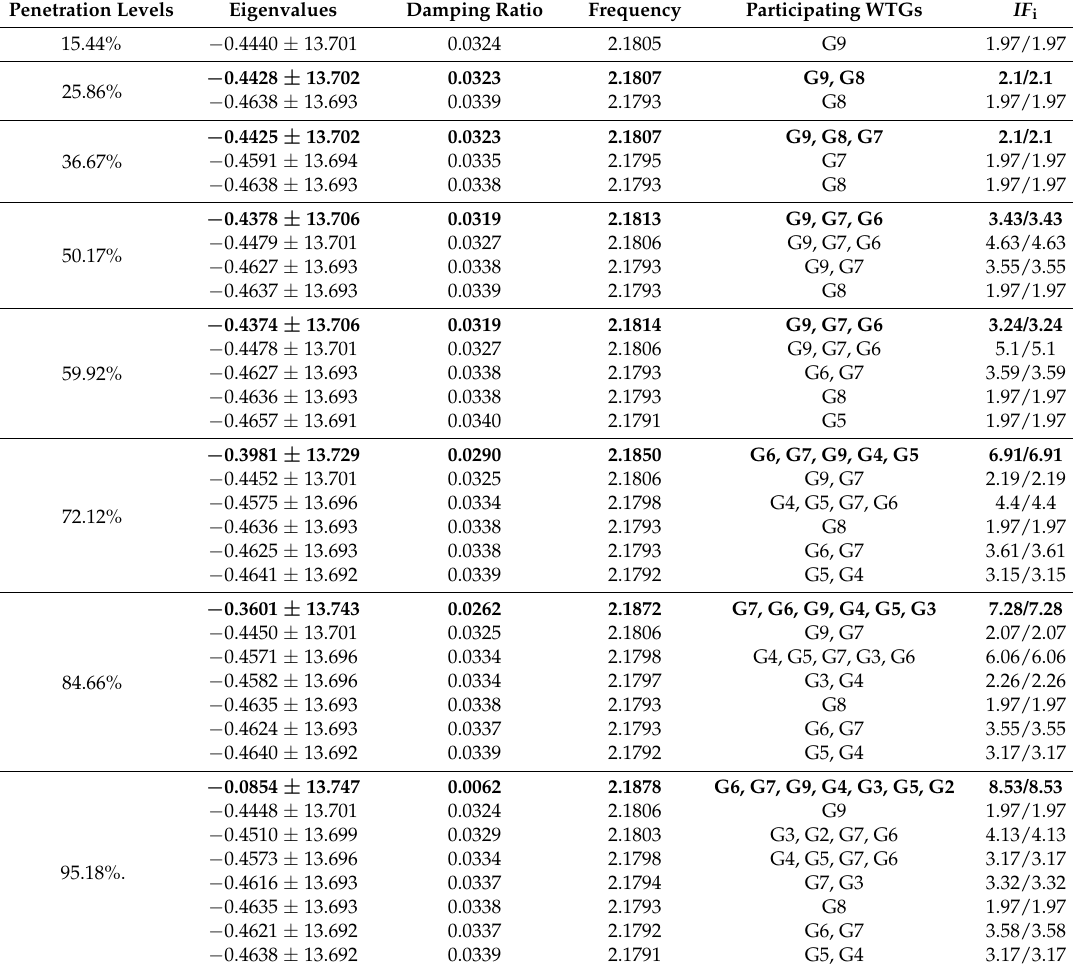
Table 4. New modes dominated by Type 4 WTGs for different penetration levels in the NETS area. Penetration